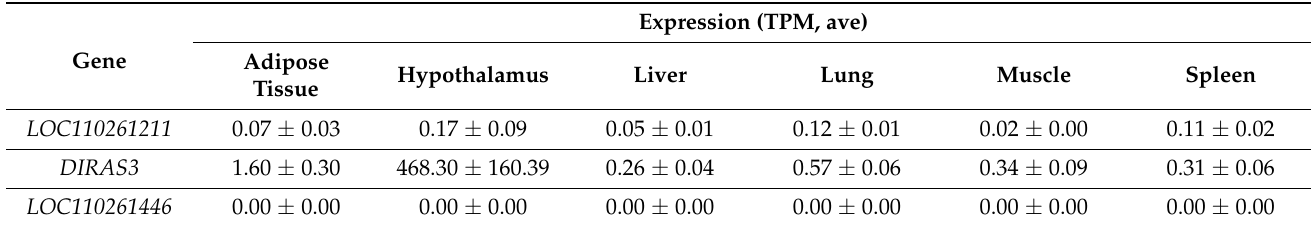
Table 2. Gene expression in various tissues of adult